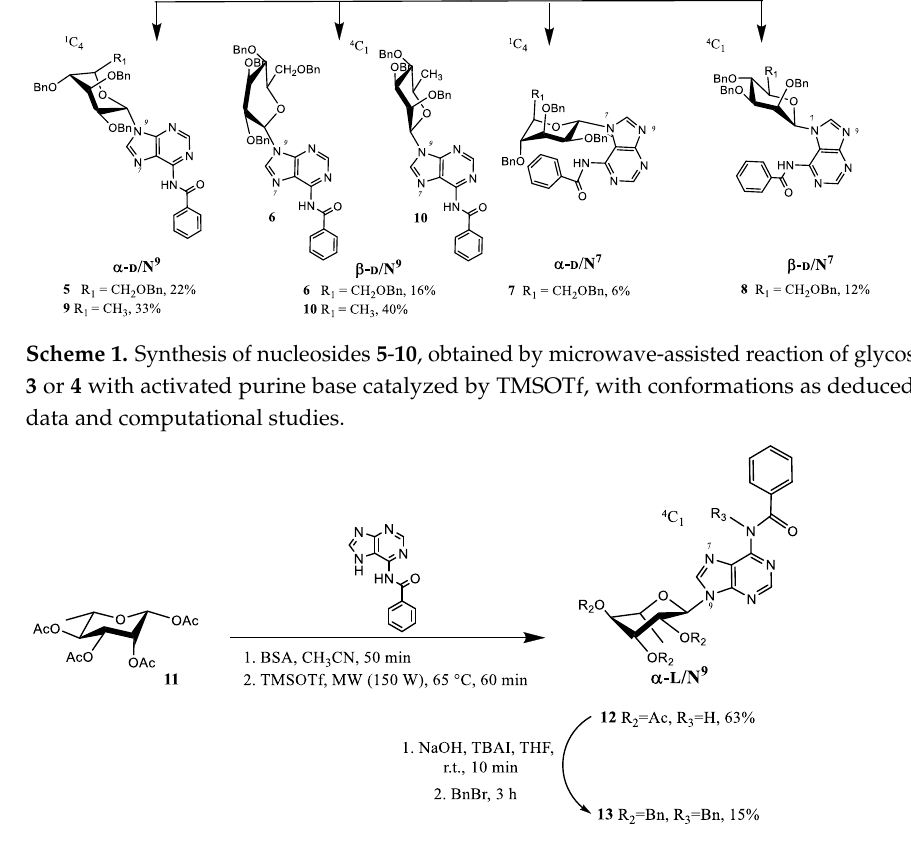
Scheme 2. Synthesis of nucleosides 12, obtained by reaction of glycosyl donor 11 with activated purine base catalyzed by TMSOTf, and 13 , obtained by benzylation reaction of compound 12 , with conformations confirmed by NMR data and computational studies .